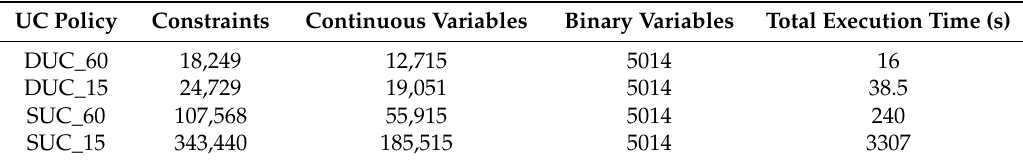
Table 3. Size of UC models and total execution